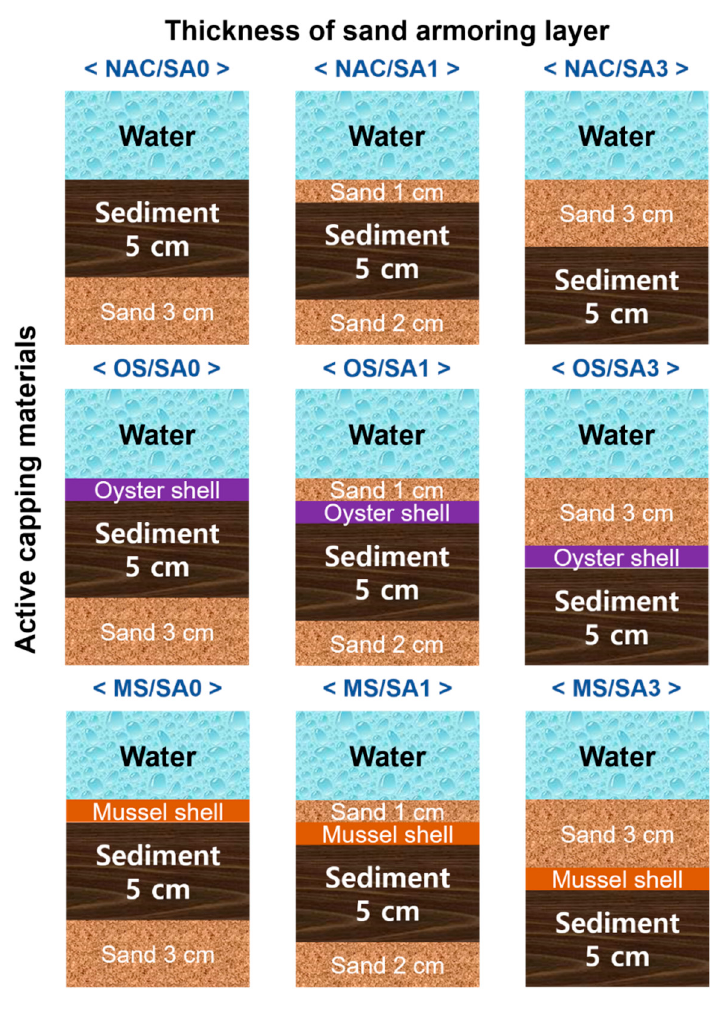
Figure 1. Experimental setup of table-size incubation systems to evaluate the efficiency of capping materials and sand armor thickness.